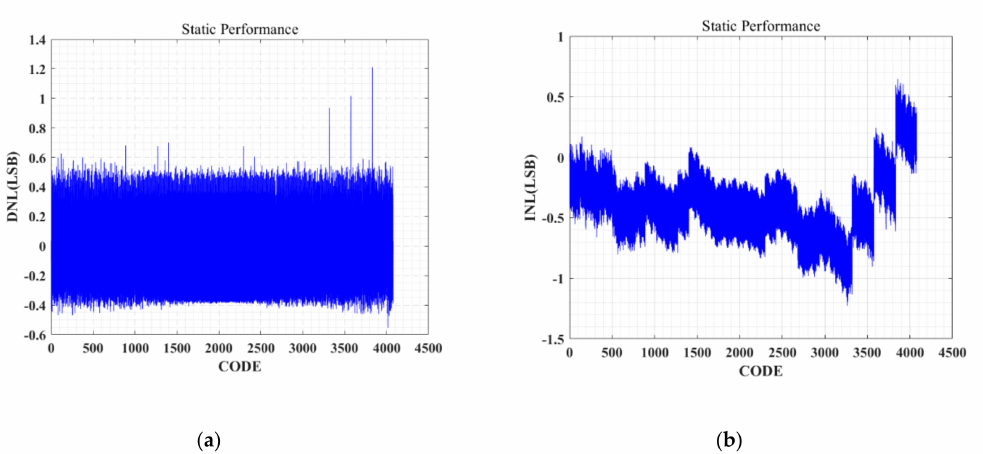
Figure 8. Measured static performance ( a ) differential nonlinearity (DNL); ( b ) integral nonlinearity (INL).